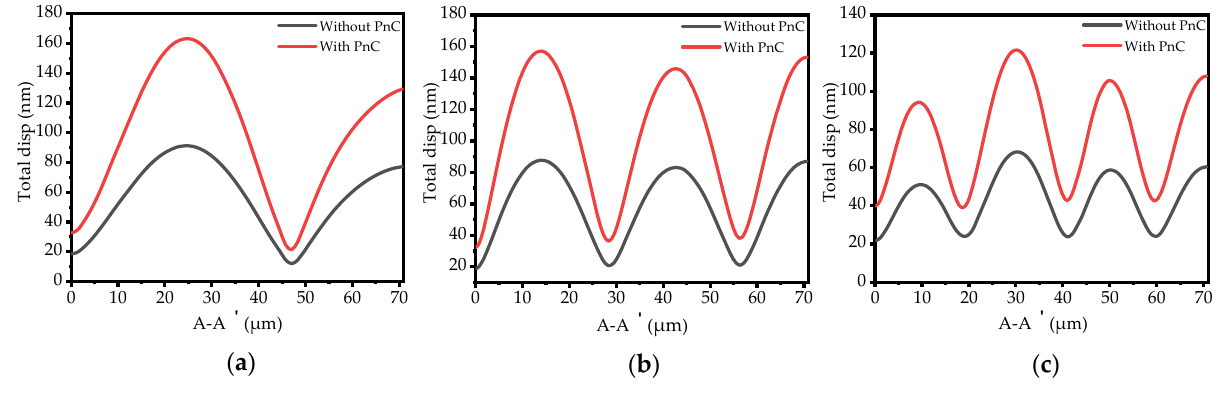
Figure 10. Illustration of the total displacement ( µ m) for the conventional resonator and the resonator with the SCC-PnC plate for the ( a ) 3rd, ( b ) 5th, and ( c ) 7th order width-extended modes on line A ‐ A, respectively.